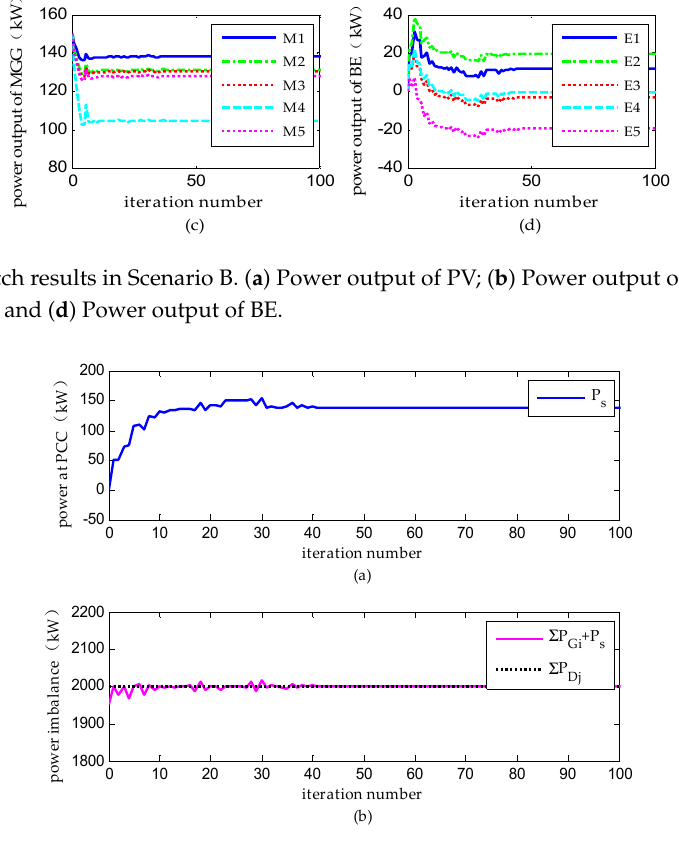
Figure 6. The simulation of power balance in Scenario B . ( a ) Power at PCC; and ( b ) The variation of power imbalance.